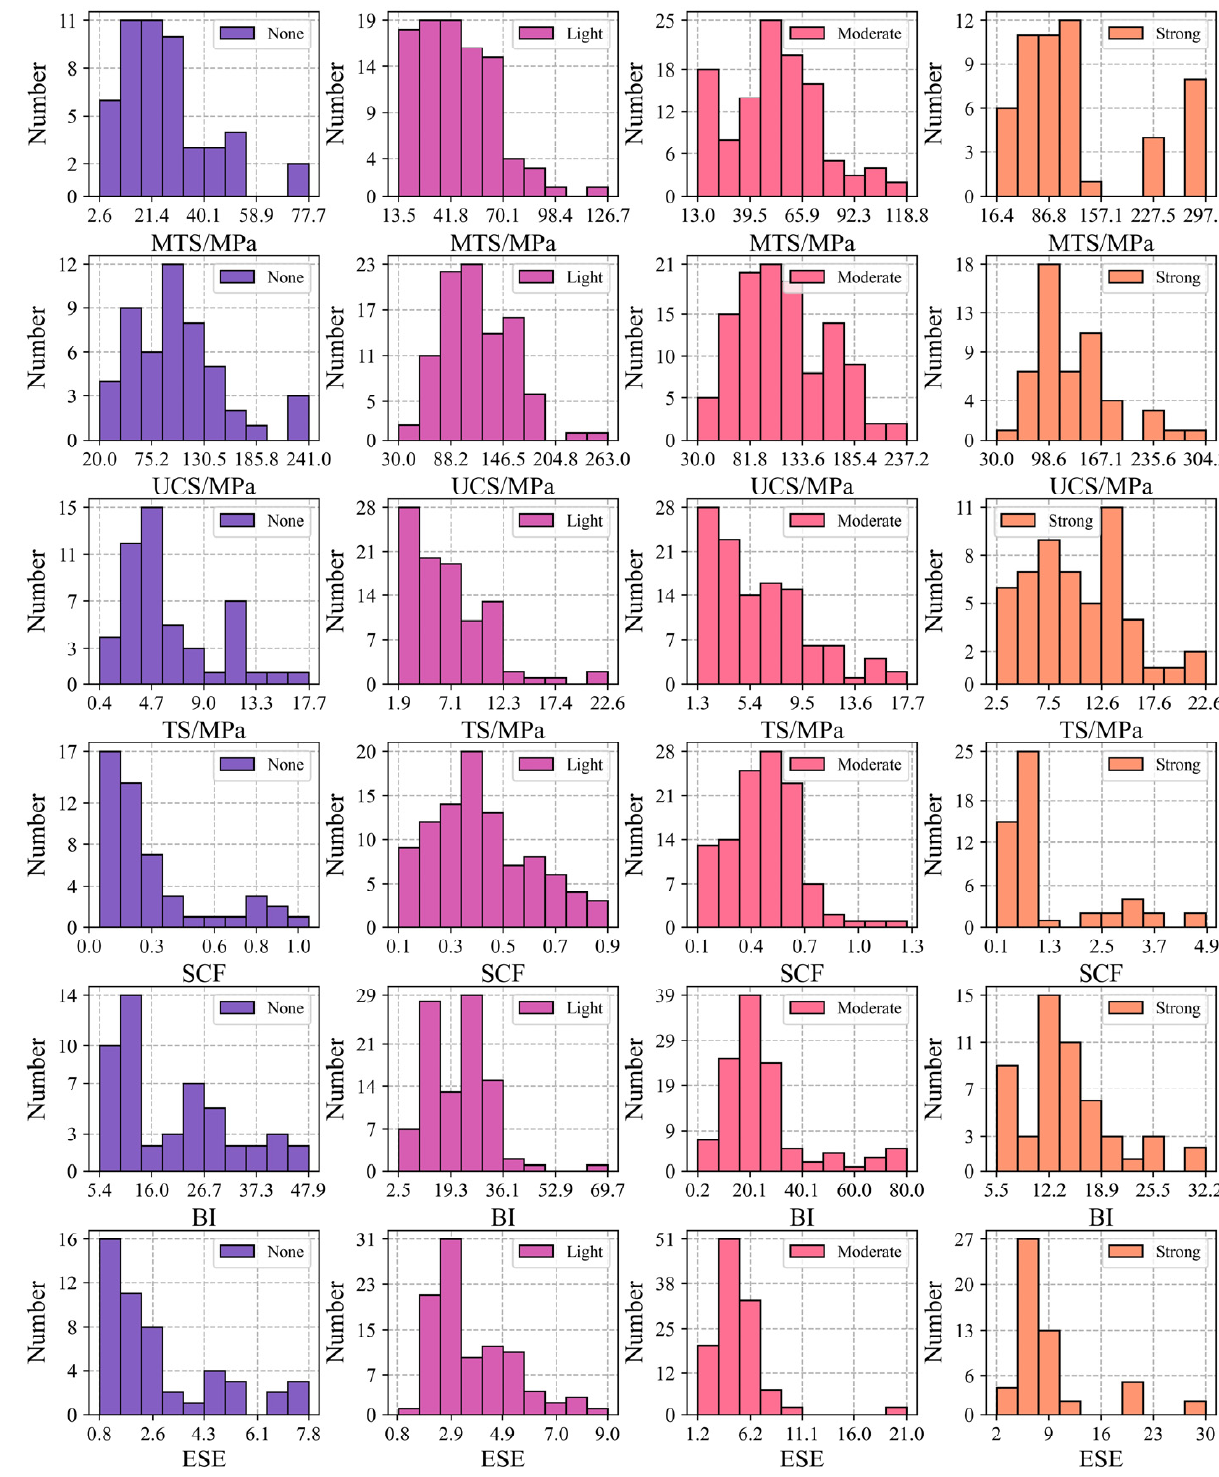
Figure 5. Histogram distribution of the database.